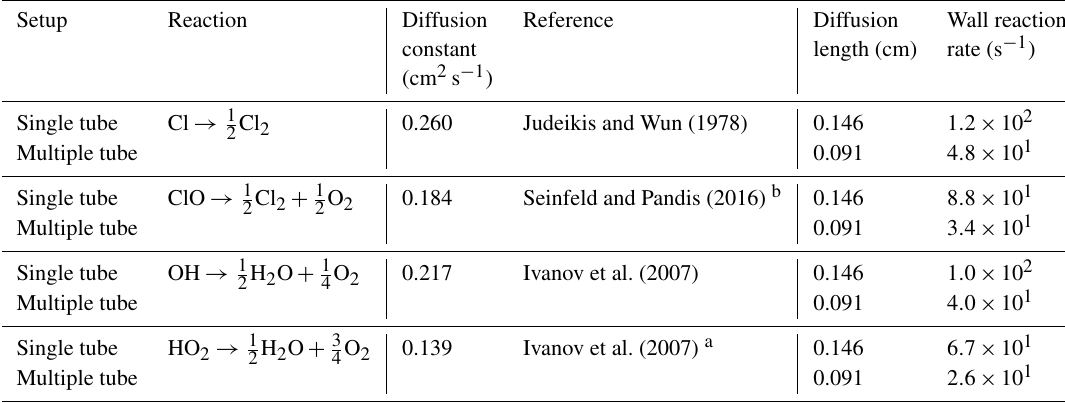
Table C1. Radical wall reaction parameters.